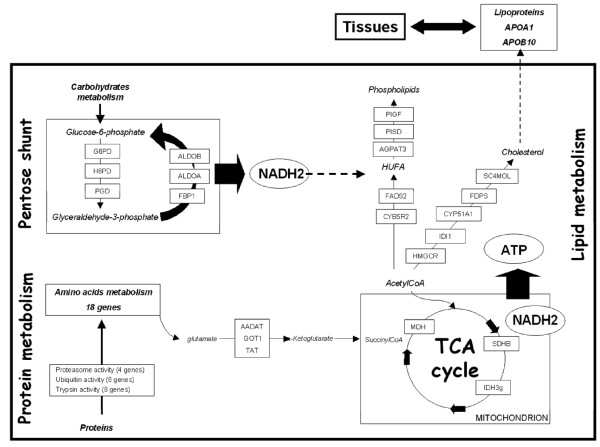
Main metabolic pathways regulated in the liver of fish fed an all-plant-based diet. Schematic view of the main metabolic pathways regulated in the liver of European sea bass fed a FM/FO free diet for 9 months. Some major metabolites are indicated in italics. The genes stimulated by the VD in the present study are indicated by their gene name in boxes.